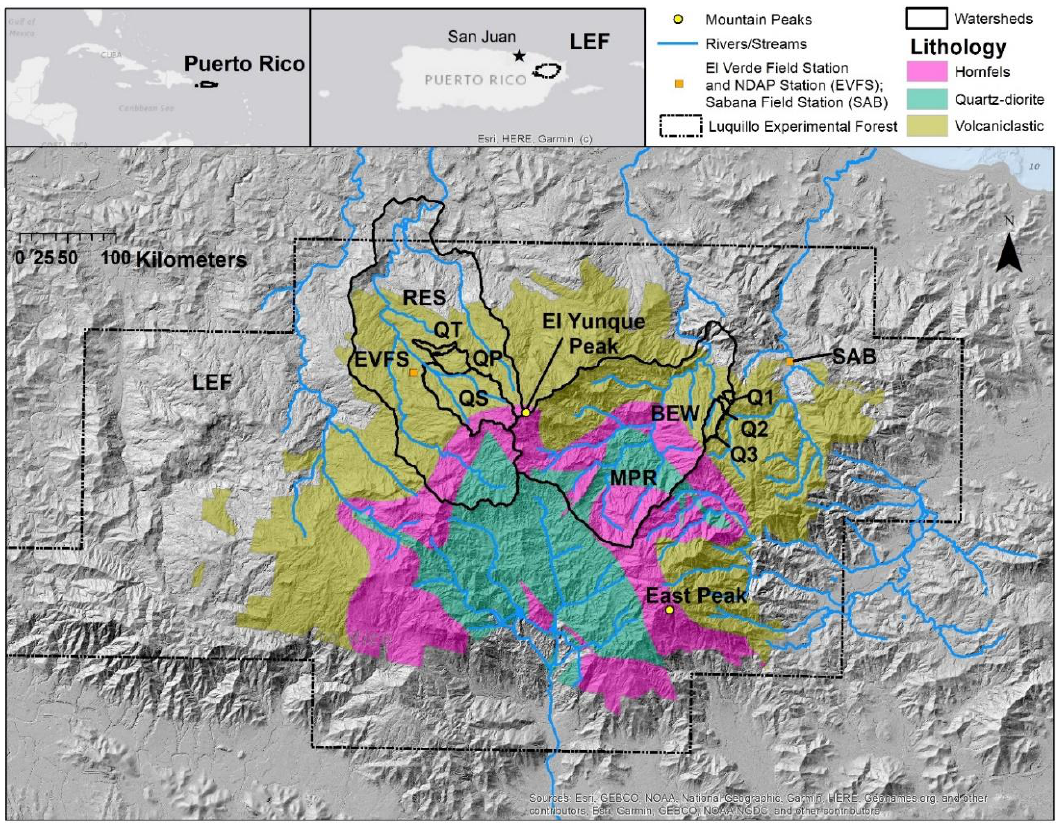
Figure 1. Map of the Luquillo Mountains of Puerto Rico and the Luquillo Experimental Forest (LEF). (panel b) Colors represent major lithology types and the watersheds discussed here. MPR: Mameyes at Puente Roto contains the subcatchments Q1-3: Bisley 1,2, and 3 (Bisley Experimental Watershed: BEW); RES: Río Espíritu Santo contains the subcatchements QS: Quebrada Sonadora; QP: Quebrada Prieta; QT: Quebrada Toronja. Inset maps show the position of the LEF in Northeastern Puerto Rico and the position of Puerto Rico in the broader Caribbean.